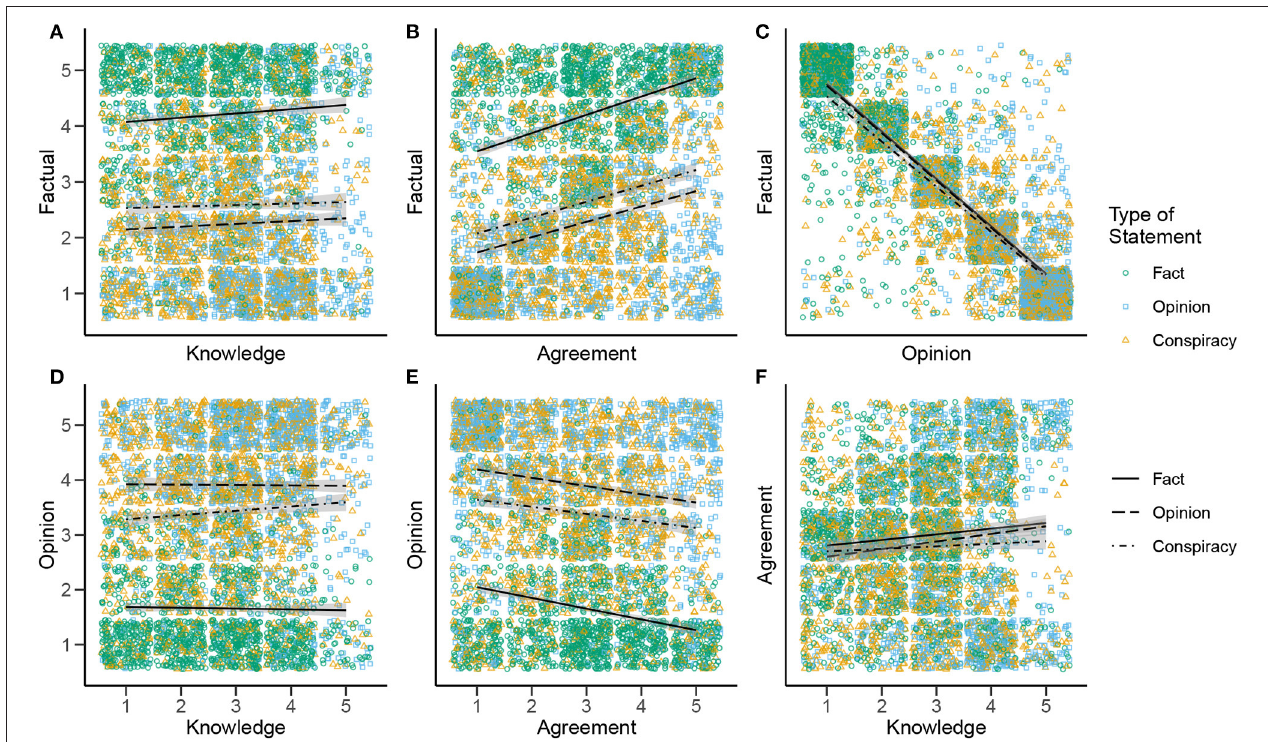
FIGURE 5 | Scatterplots of bivariate relationships between Factual × Knowledge (A) , Factual × Agreement (B) , Factual × Opinion (C) , Opinion × Knowledge (D) , Opinion × Agreement (E) , and Agreement × Knowledge (F) rating scales in Study 2. The three different types of stimulus statement (Fact, Opinion, and Conspiracy) are represented as differently colored and shaped points. Linear trend lines are included, with different line types representing trends for the three types of stimulus